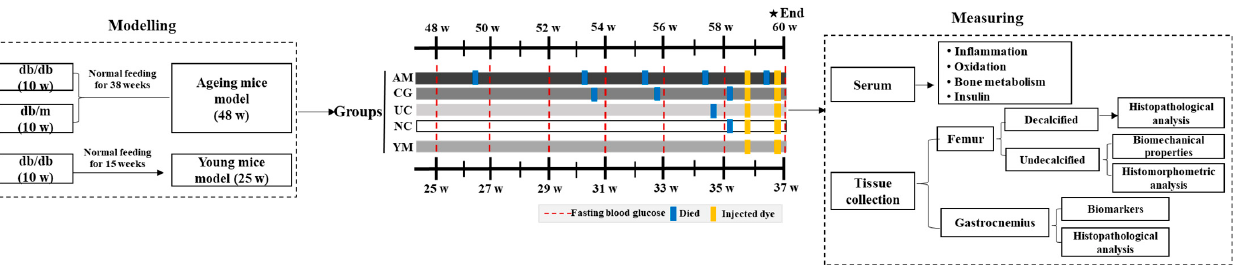
Figure 7. Schematic plot and the timeline of the research protocol. Normal deaths were marked with blue. Injection of alizarin-3-methyliminodiacetic acid and calcein was performed in one-week intervals ( n = 5 mice per group per timepoint) (marked with yellow). Fasting blood glucose and insulin measurements were performed each week (in all the survived mice per group per timepoint) and at the end stage ( n = 5 injected mice per group).